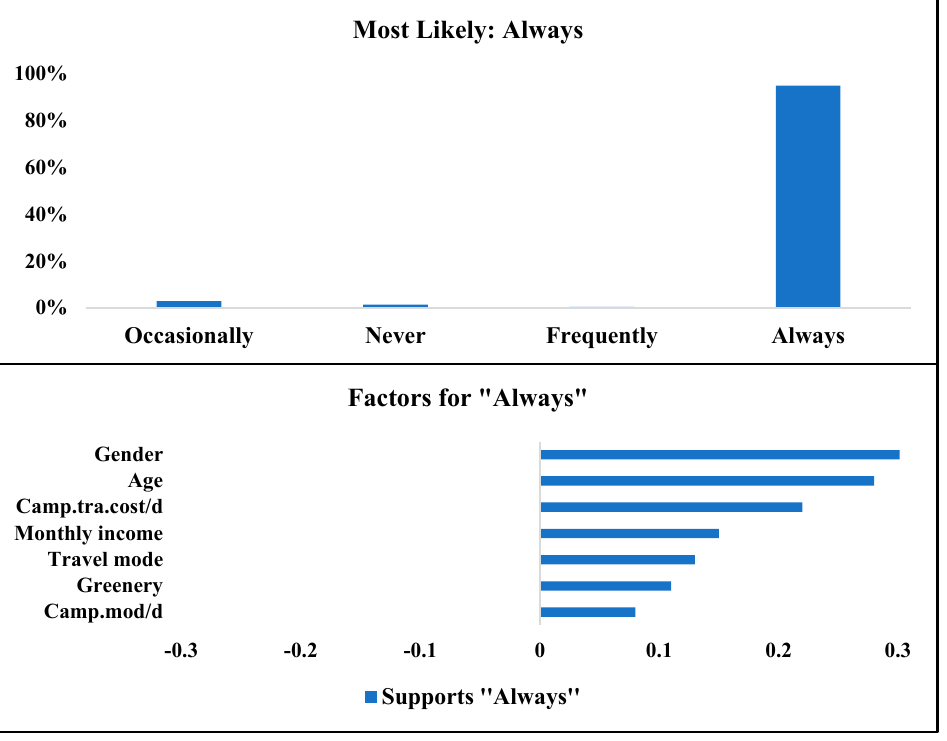
Figure 15. Optimization results and importance of variables based on the first scenario: Always use SFFESs.